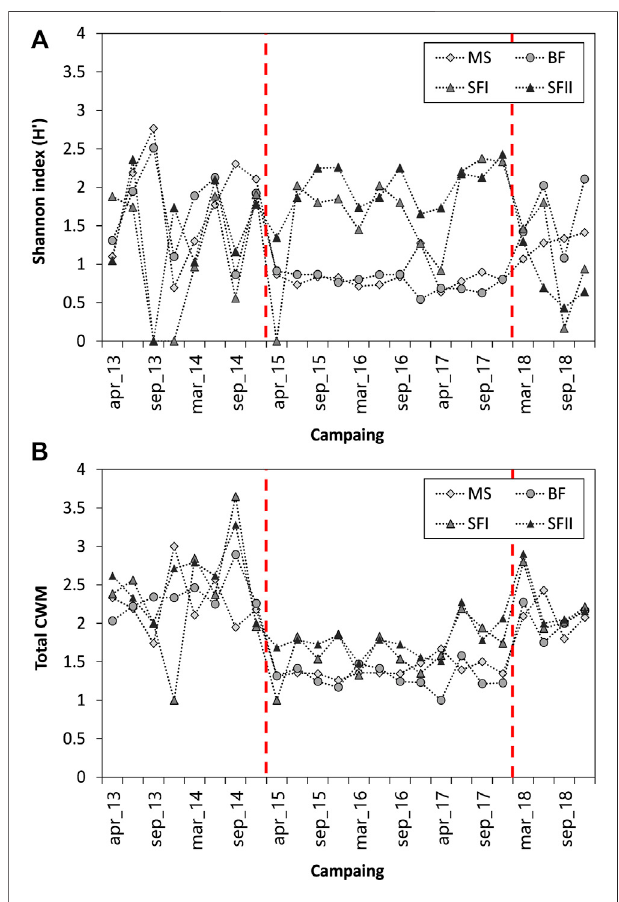
FIGURE 6 | Temporal variation of (A) Shannon Diversity Index and (B) Community Weighted Mean (CWM) sampled from 2013 to 2018 in the three Small Hydroelectric Power Plant (SHP) reservoirs: Monte Serrat (MS; n = 24), Bonfante (BF; n = 24) and Santa Fé (SF I and II; n = 24). The red dashed lines indicate the periods of signi fi cant changes in the dominance of the main phytoplankton